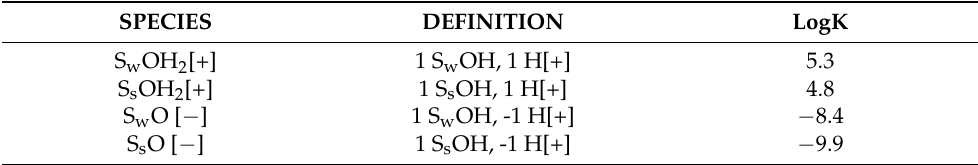
Table 2. Properties of the surface functional groups of the clay used in this study. The reactions and constants are expressed according to the CHESS code used for calculating them [23]. SPECIES DEFINITION